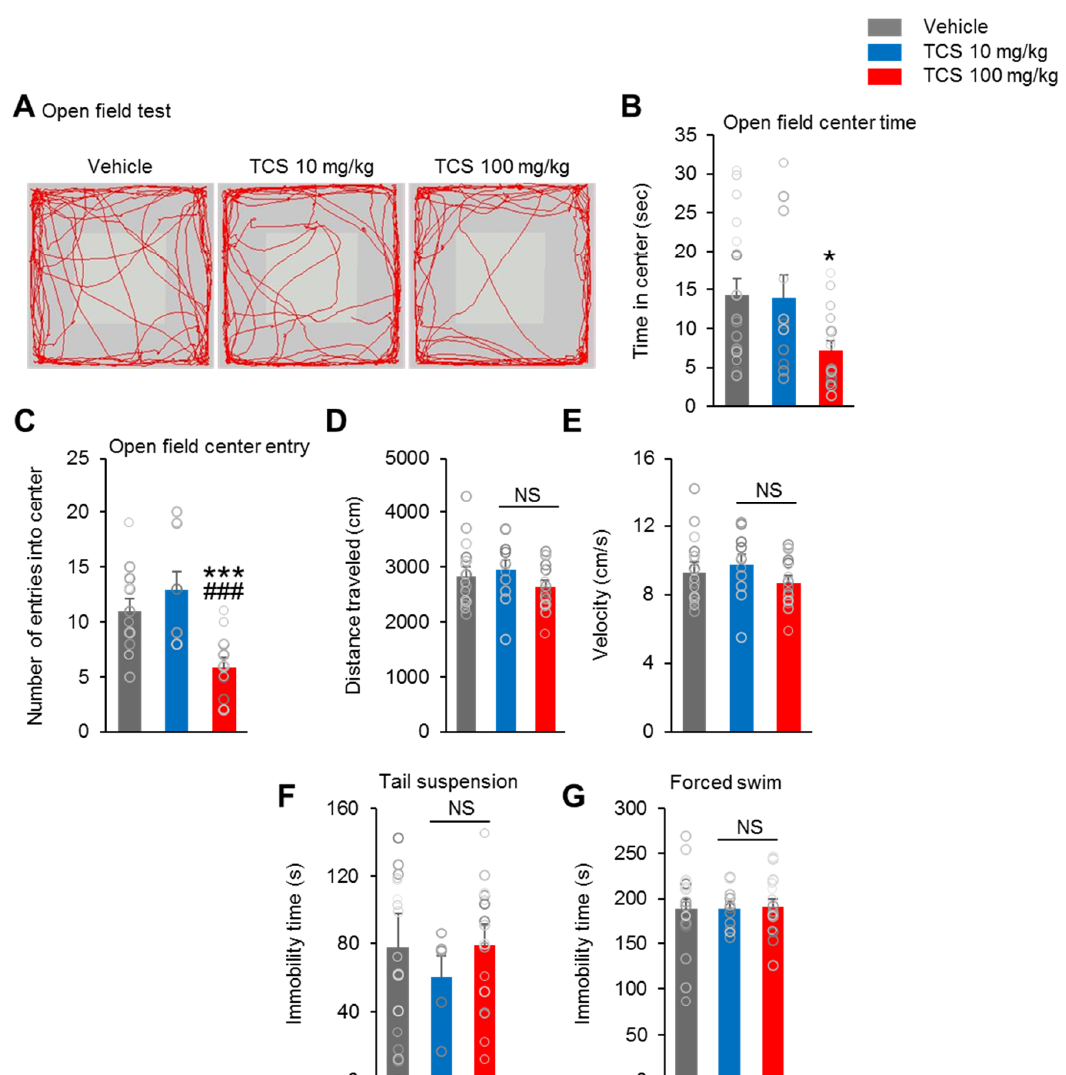
Figure 5. TCS impair locomotor activity, anxiety-like behavior and nesting- behavior in mice. ( A ) Representative tracing of mouse travel in the open field test. ( B – E ) Quantification of A . The time spent in the center, the number of entries into the center, distance traveled and velocity in the open field were examined in the open field. TCS 100 mg/kg group showed reduction of both open field center time and open field center entry compared to vehicle and TCS 10 mg/kg group. TCS-treated groups exhibited no difference in distance traveled and velocity in open field. n = 18 mice (seven male, 11 female) for vehicle, 11 mice (eight male, three female) for TCS 10 mg/kg, 17 mice (10 male, seven female) for TCS 100 mg/kg. * p < 0.05 vs. vehicle, *** p < 0.001 vs. vehicle, ### p < 0.001 TCS 10 mg/kg vs. TCS 100 mg/kg. NS, no significance. ( F ) In tail suspension test, TCS-treated group showed no difference in the immobility times compared to vehicle group. ( G ) In forced swimming test, there was no changes in the immobility times between vehicle and TCS-treated groups. n = 18 mice (seven male, 11 female) for vehicle, 11 mice (eight male, three female) for TCS 10 mg/kg, 17 mice (10 male, seven female) for TCS 100 mg/kg. Data represent mean ± SEM. Statistical significance was determined by one-way ANOVA with Bonferroni correction. NS: no significance. However, the TCS 10 mg/kg group showed no difference in time spent in the open field center compared to that of the vehicle and TCS 100 mg/kg groups (Figure 5B). Additionally, compared to the vehicle group, there were significantly fewer open field center entries in the TCS 100 mg/kg group but no difference in entries in the TCS 10 mg/kg group (F 2,43 = 13.75, p < 0.0001) (Figure 5C). Moreover, the TCS 100 mg/kg group displayed significantly lower open field center entries compared to those of the TCS 10 mg/kg group (Figure 5C). However, the number of entries into the center zone in the TCS 10 mg/kg and vehicle groups were not significantly different (Figure 5C). There were no differences in distance traveled (Figure 5D) between the vehicle and TCS 10 mg/kg or TCS 100 mg/kg groups (F 2,43 = 1.317, p = 0.4436). In addition, the TCS-treated groups showed no difference in velocity compared to vehicle group (F 2,43 = 1.275, p = 0.4637) (Figure 5E). There was also no significant difference in velocity and distance traveled between the TCS 10 mg/kg and TCS 100 mg/kg groups (Figure 5D,E). Taken together, the results indicate that perinatal exposure to TCS elevates anxiety- like behavior in offspring mice. Next, we examined the potential of TCS to induce depression by assessing depressive-like behavior based on using tail suspension and forced swimming tests. The results showed that the immobility times of TCS-treated groups were not significantly different from the vehicle group in the tail suspension test (F 2,34 = 0.4342, p = 0.5535) (Figure 5F). There was also no significant difference in the immobility times of the TCS 10 mg/kg and TCS 100 mg/kg groups (Figure 5F). The forced swimming test results revealed no significant differences between the TCS-treated groups and the vehicle group (F 2,34 = 0.02233, p = 0.0522) (Figure 5G). These results show that perinatal exposure to TCS does not affect the exhibition of depression-like behavior in offspring mice. 2.7. TCS-Exposure Reduces Nesting-Behavior in Mice Nesting behavior is a motivated, goal-directed activity requiring orofacial and forelimb dexterity. To quantify the nesting behavior of offspring mice at six-weeks of age, we used Deacon’s five-point rating system. Vehicle-treated mice-built nests perfectly and within 12 h, leaving no unshredded pieces of nestlet material (Supplementary Figure S3A). In contrast, both the TCS 10